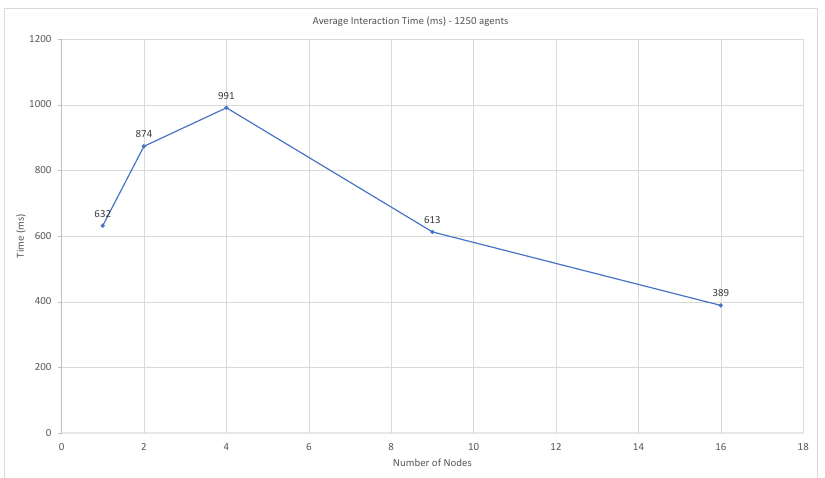
Figure 8. Interaction time (ms) for 1250 agents on 1, 4, 9, and 16 nodes, using data from Section 2.2.1 with cellular morphology features.